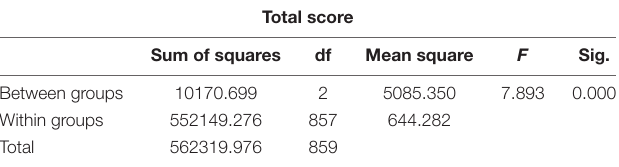
TABLE 7 | The results of ANOVA for age. Total score Sum of squares df Mean square F Sig.